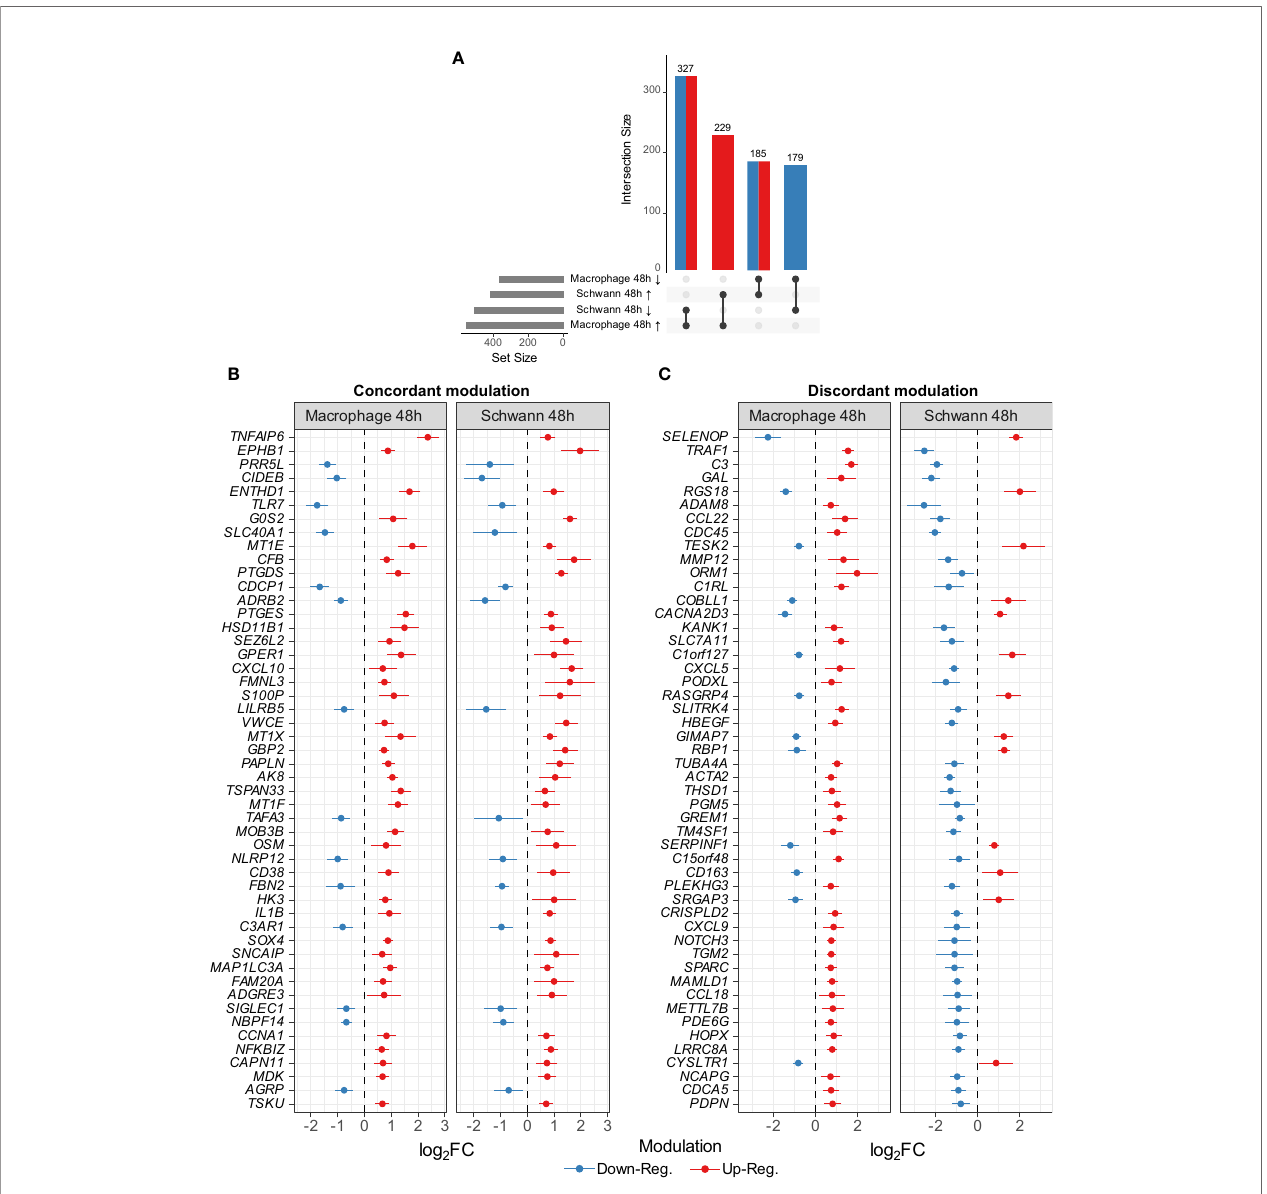
FIGURE 3 | Common DEGs between this study and Schwann cells infected with M. leprae (MOI 1:100 for 48 h) [GSE35423] (12). (A) The number of commonly DEG by dataset and modulation sign passing |log 2 FC| ≥ 0.26 and FDR ≤ 10% in both datasets. Arrows indicate ( ↑ ) upregulation and ( ↓ ) downregulation. Top 50 DEG common to both datasets modulated in the same manner (B) or oppositely (C) . Points represent log 2 FC (unstandardized) from each dataset original differential expression analysis alongside error lines indicating nominal 95% con fi dence intervals. All genes shown have an FDR ≤ 10% and a difference in mean expression of at least 56% ( ≈ 0.65 log 2